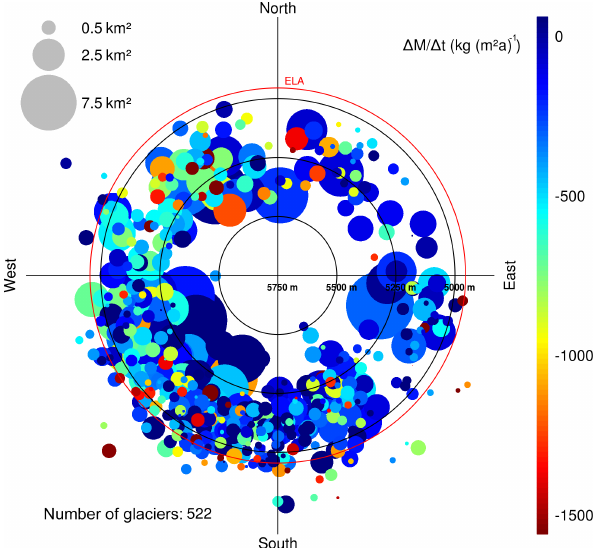
Figure 7. Polar plot of specific mass balance (dot colour) of indi- vidual glaciers in subregion R1 in the period 2000–2016 of individ- ual glaciers. Dot size: glacier size in 2000; radius: median eleva- tion; orientation: mean aspect. Red circle: equilibrium line altitude (ELA); see also Table S3. Note: only glaciers with elevation change information >50% are included. Plots for other subregions and time intervals are provided in the Supplement.